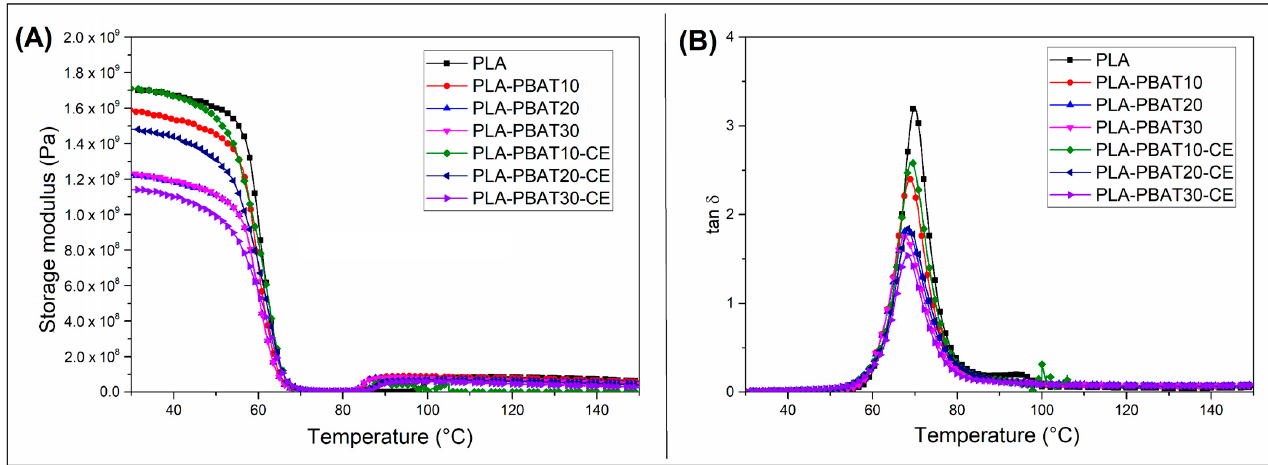
Figure 3. DMTA analysis results for injection molded blends. ( A ) storage modulus curves, and ( B ) tan δ results.